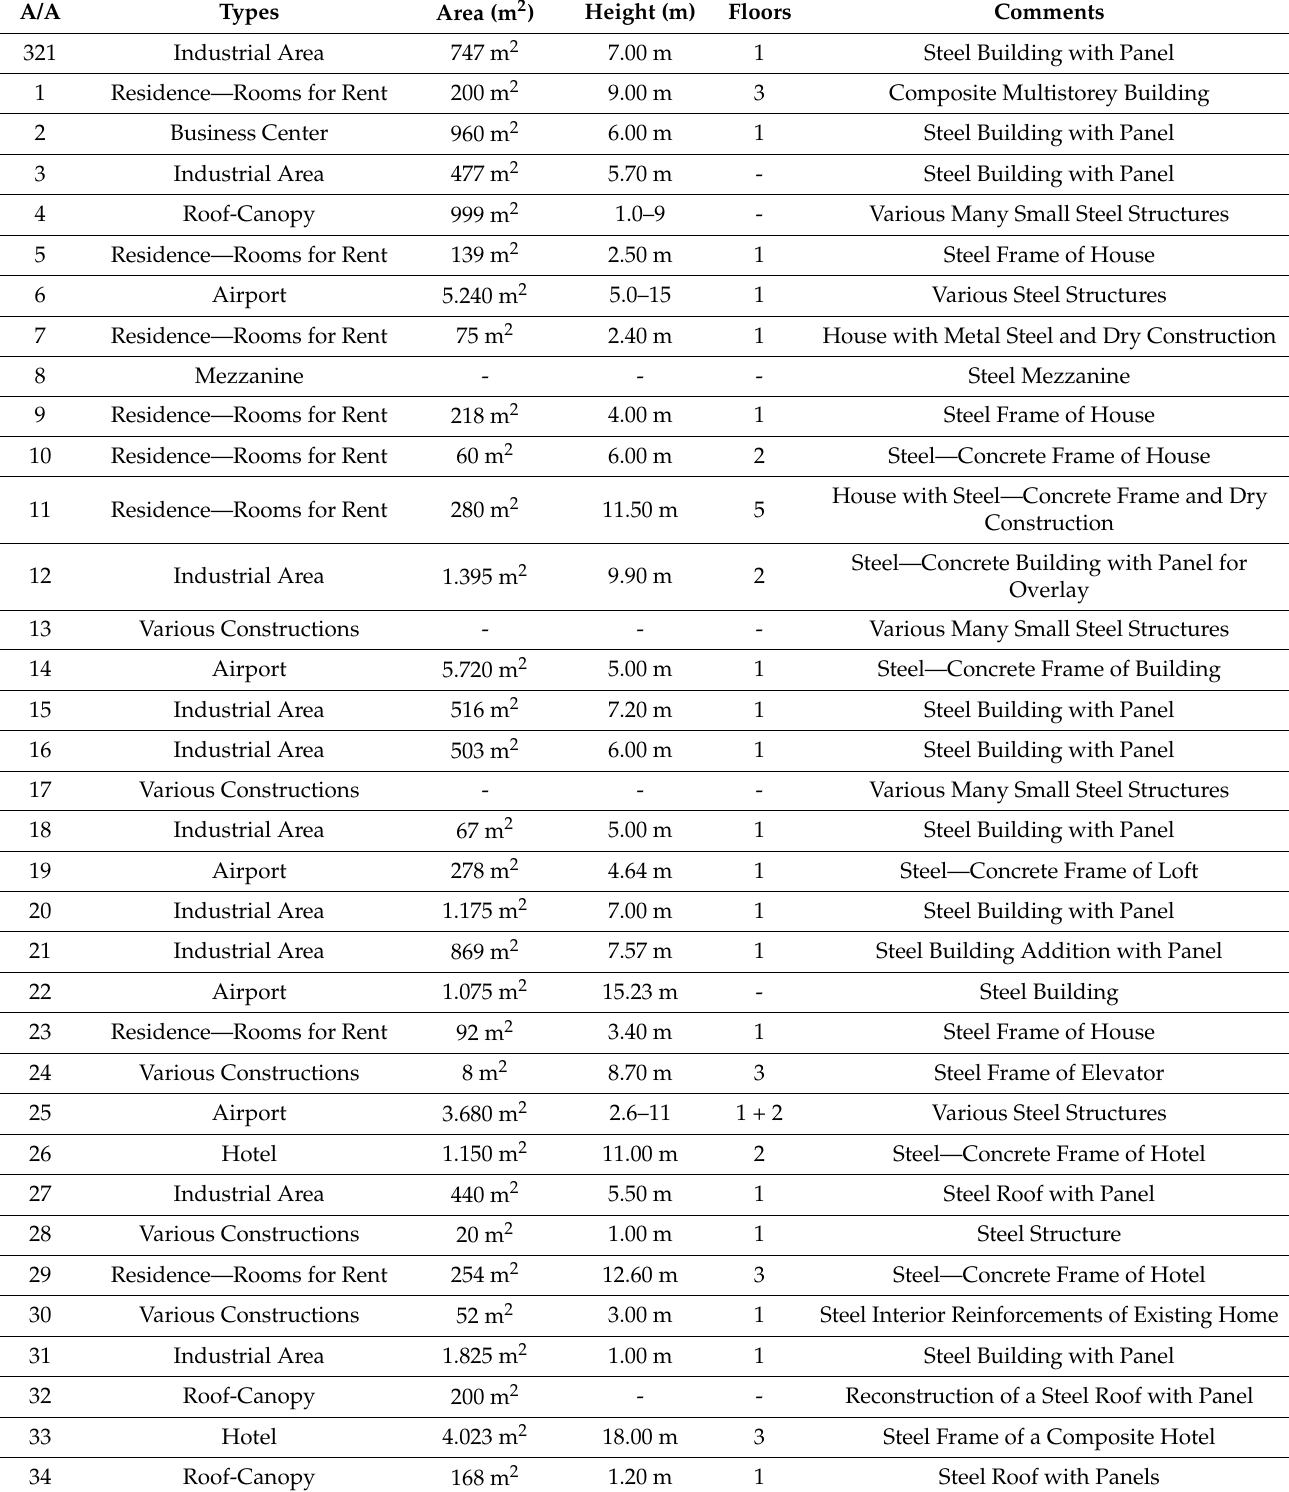
Table A1. The main characteristics of the